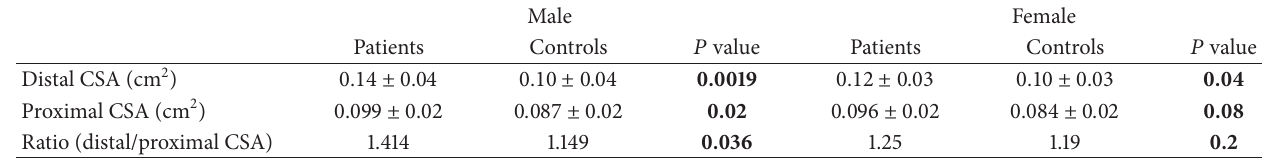
Table 3: Distal and proximal cross-sectional area (CSA) of median nerve including ratio (distal/proximal CSA).